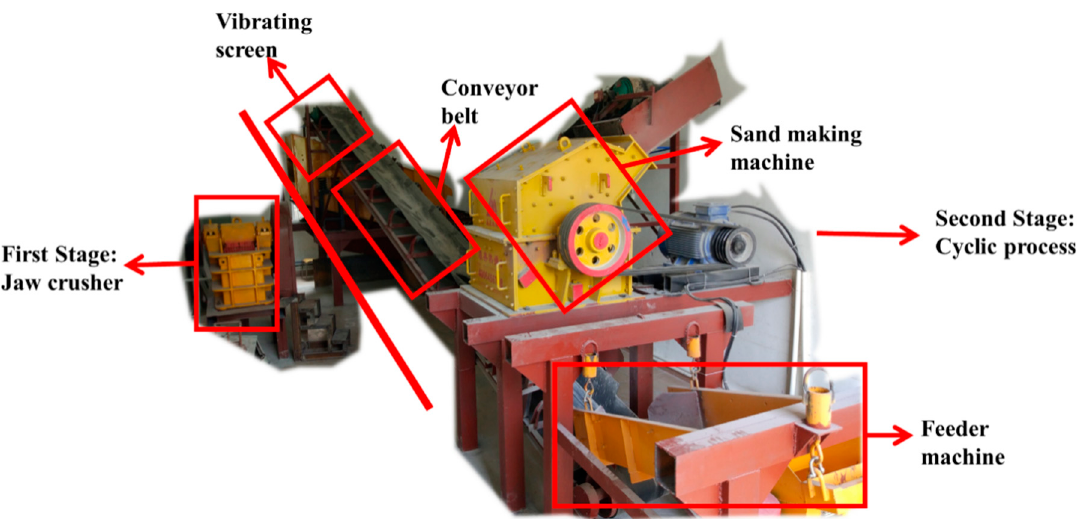
Figure 1. The equipment for the production of the completely recycled fine aggregate (CRFA) on a pilot